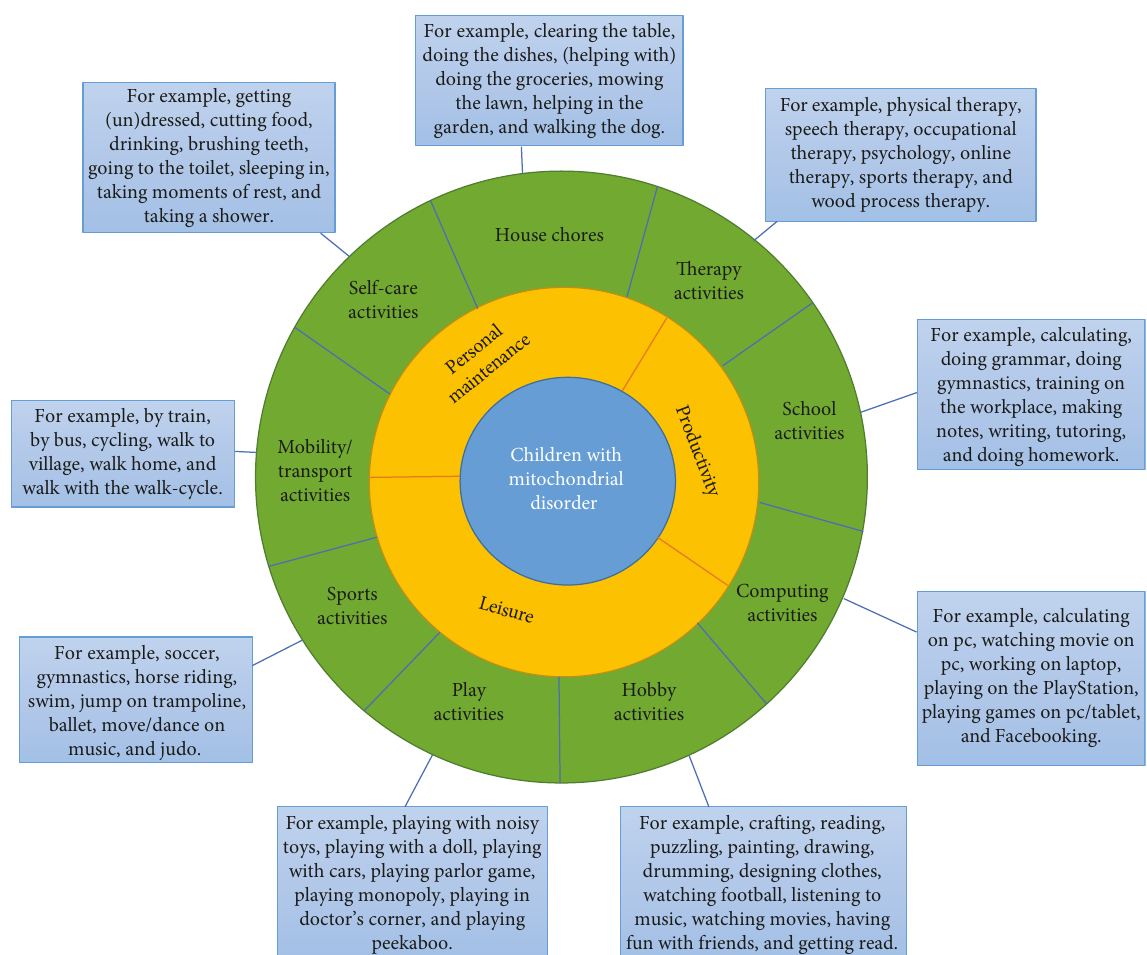
Figure 1: Activities, activity categories, and occupational performance areas of children with mitochondrial